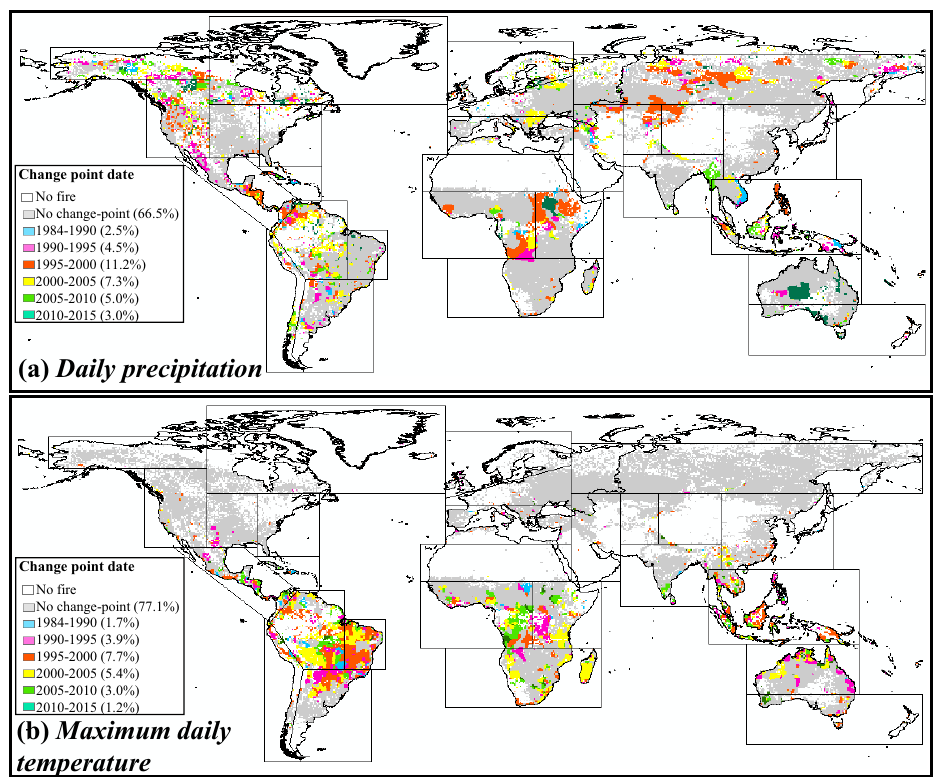
Fig. 3 Global map-1 showing the distributions of the change-points. This global map-1 shows the distributions of the change-points of the daily precipitation andmaximum daily temperature on a monthly scale. The map is marked with grids of significantchange-points, where different colors indicate when an abrupt change occurs. Blanks in the figureindicate areas without wildfires. Numbers in parentheses indicate the percentage of